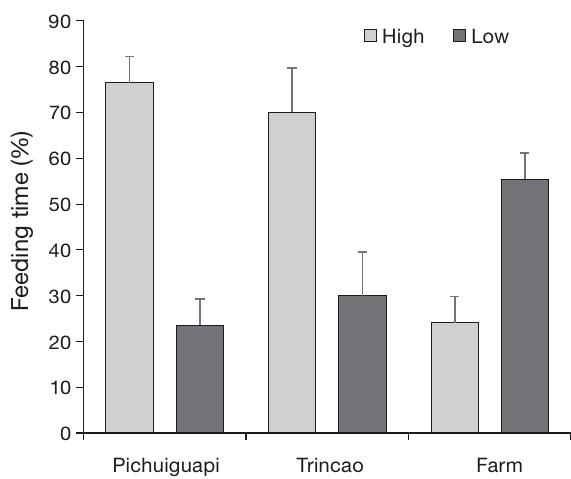
Fig. 4. Mean ± SE of total observation time that flightless steamer ducks dedicated to feeding during high and low tide at each study site within Yaldad Bay between March 1988 and February